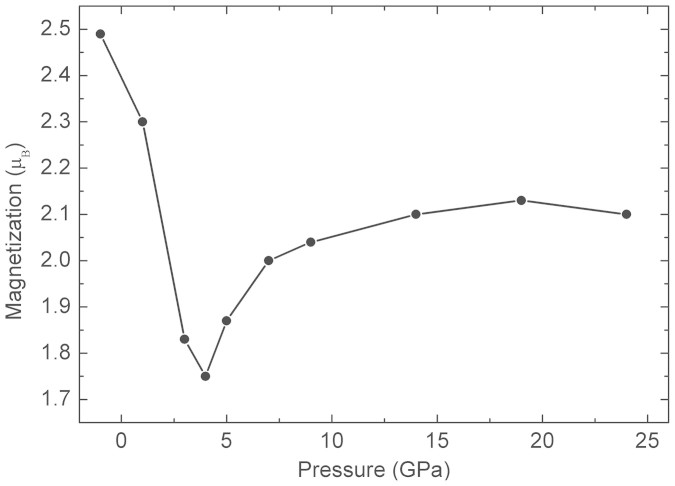
Calculated magnetization per unit cell of NaFe2As2 as a function of pressure.